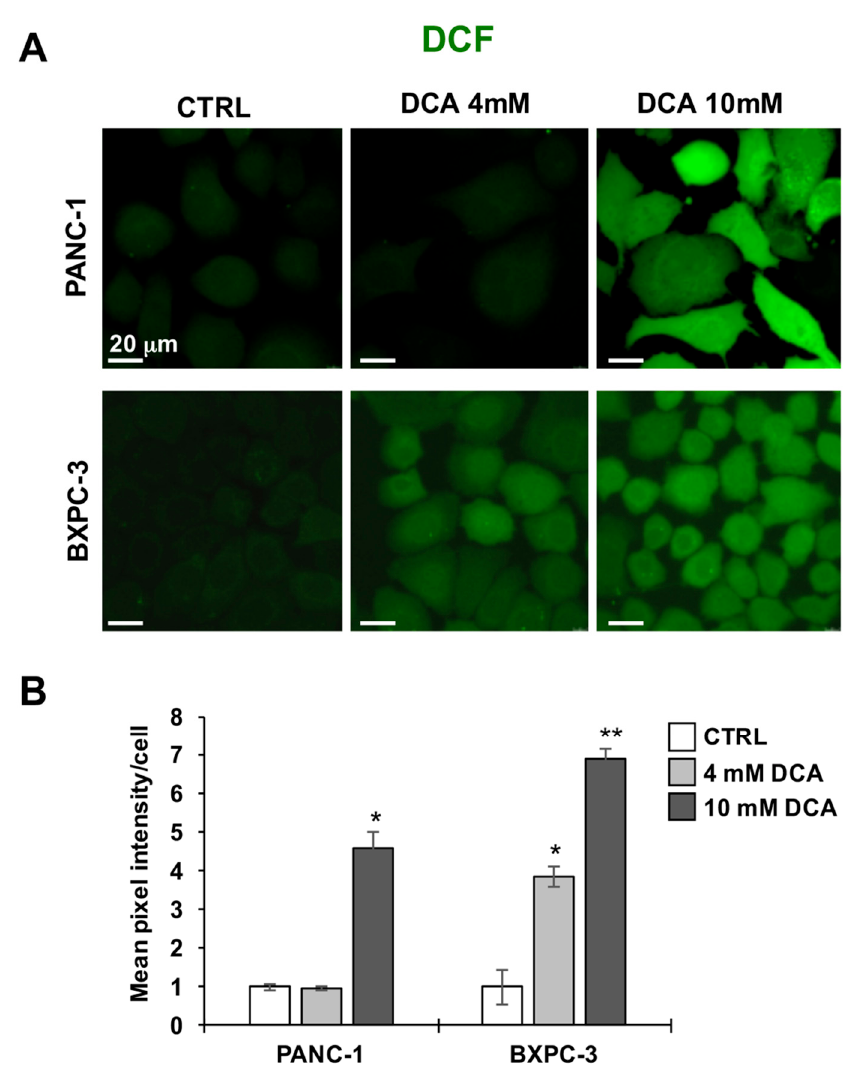
Figure 5. E ff ect of DCA on ROS production in PANC-1 and BXPC-3 cell lines, ( A ) representative LSCM imaging of ROS production in living PANC-1 (upper panel) and BXPC-3 (lower panel) cells treated with DCA assessed by DCF, images are representative of three di ff erent preparations yielding similar results; ( B ) histogram showing the quantitative analysis of the DCF-related fluorescence / cell, the values are means ± SEM of three independent experiments under each condition where the digitalized fluorescence images from at least five randomly selected optical fields (each containing about 25 cells) were analyzed; * p < 0.01, ** p < 0.001 vs. CTRL.